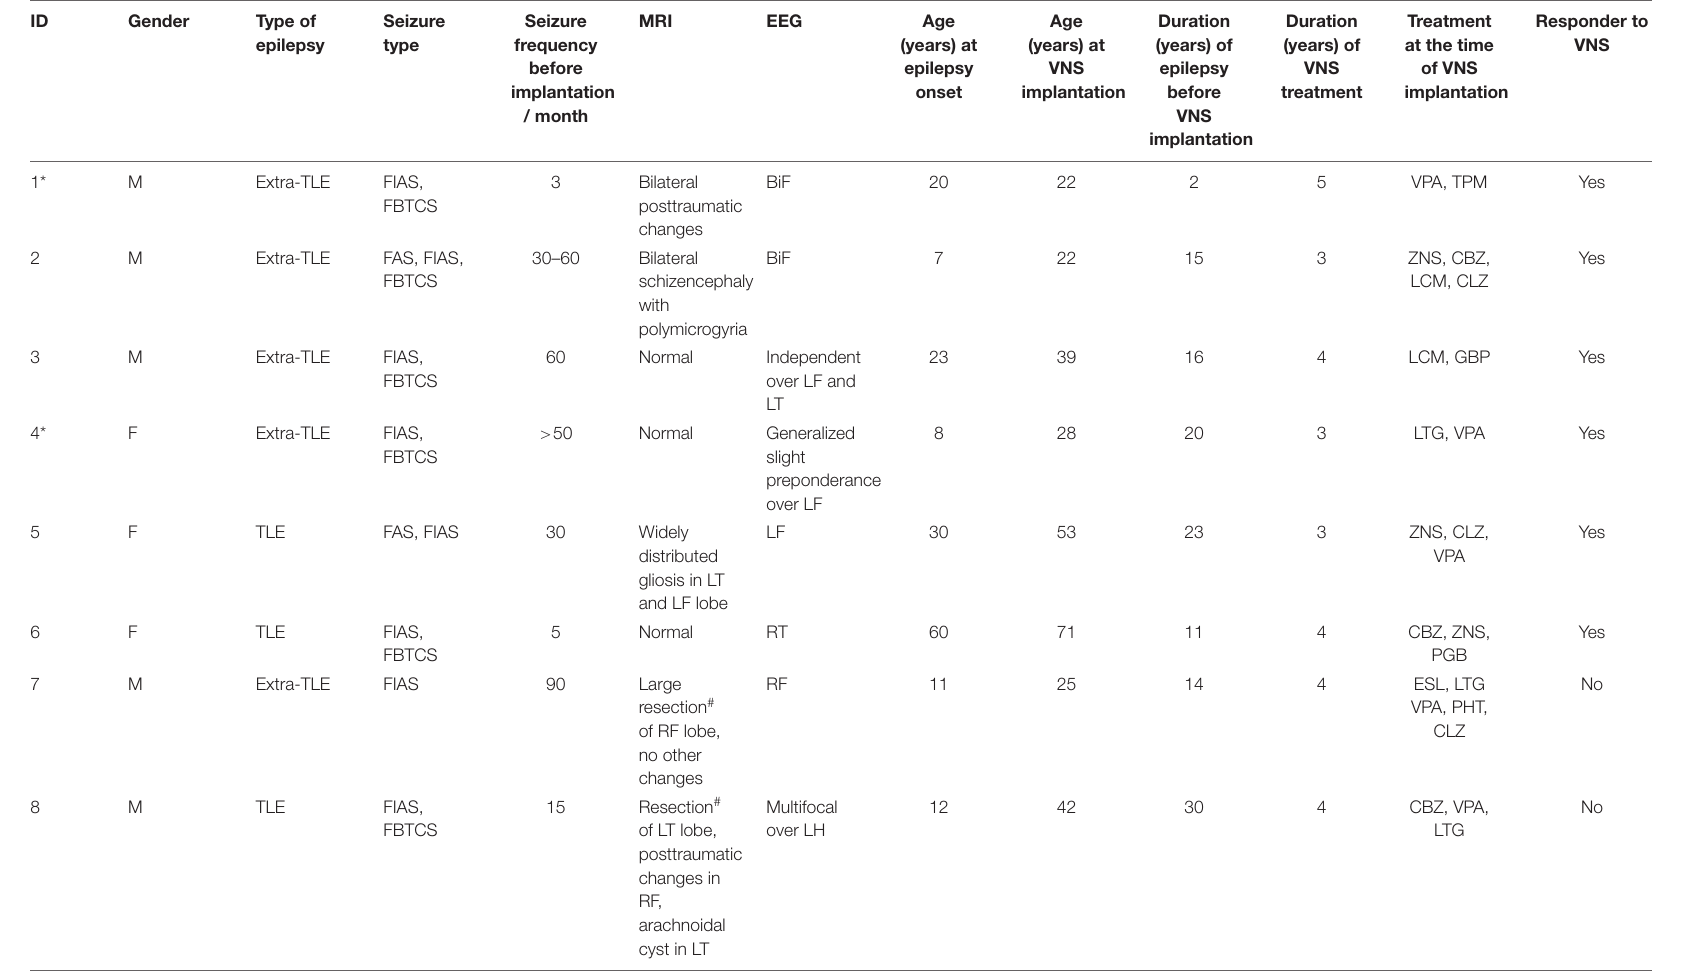
*incorrectly classified patient. # surgery for drug-resistant